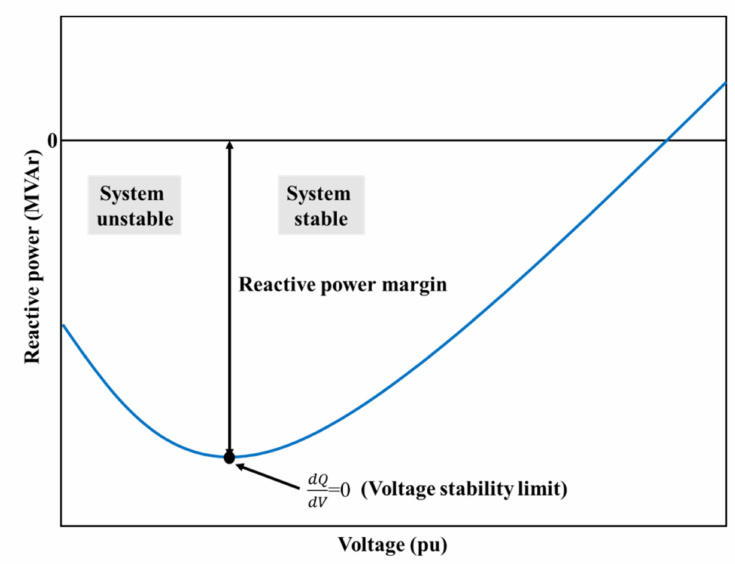
Figure 1. A typical reactive power vs. voltage (Q–V) curve at a load bus